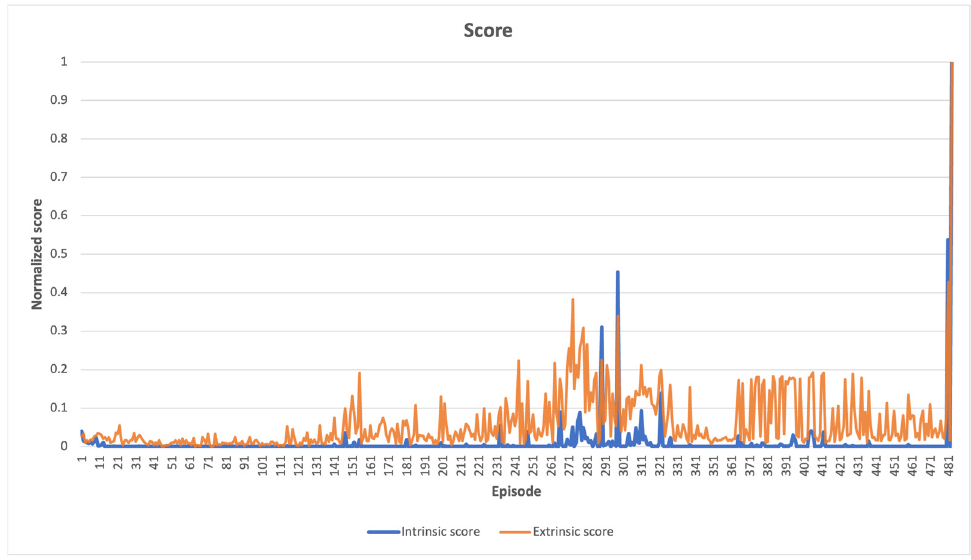
Figure 4. CartPole-v1 learning scores, where both intrinsic and extrinsic fluctuate greatly, indicating the complexity of the search space.